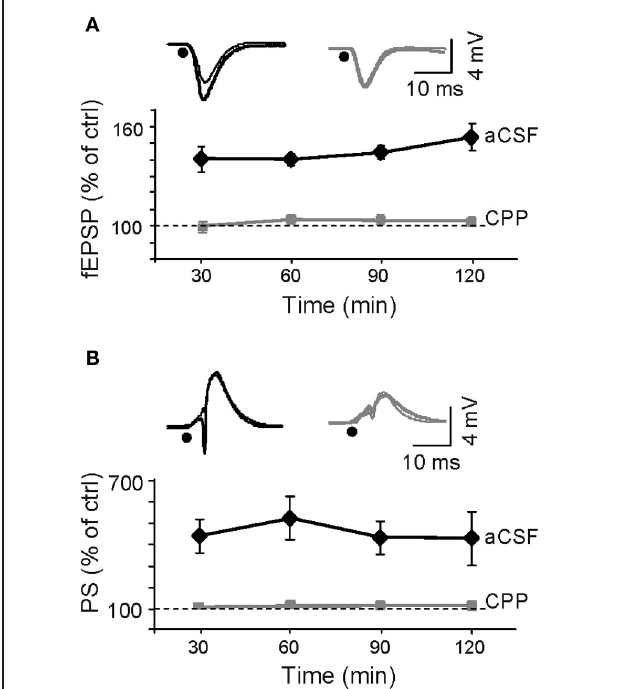
FIGURE 2 | Assessment of LTP induction by Schaffer-evoked field potentials. LTP was induced by a burst stimulation protocol (BS: see “Materials and Methods”). (A,B) Initial fEPSP slope and the amplitude of the population spike (PS). Sample traces shown above the plots correspond to control (thin) and 1h post-BS (thick) in representative experiments following prior application of aCSF (black) or CPP (gray), respectively, (black dots mark the time of stimulation). LTP of Schaffer-evoked responses was blocked by injection of the NMDA receptor’s blocker in the vicinity of the probe at recording site in the stratum